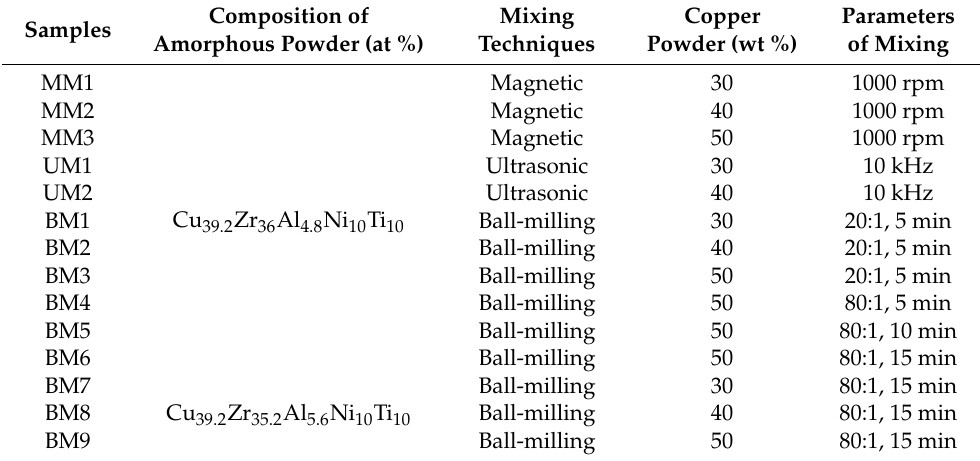
Table 1. Techniques and